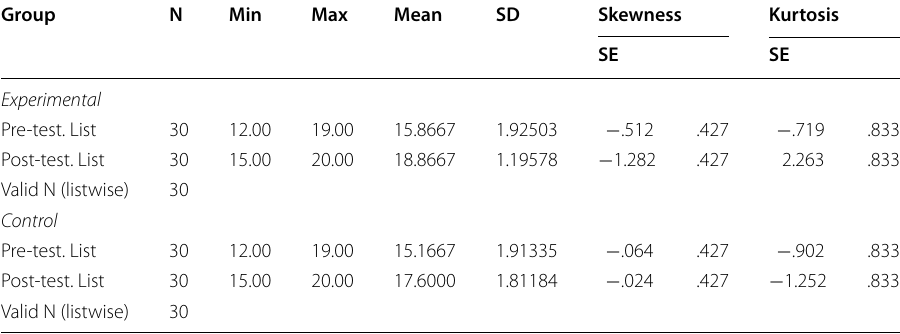
Table 12 Descriptive statistics